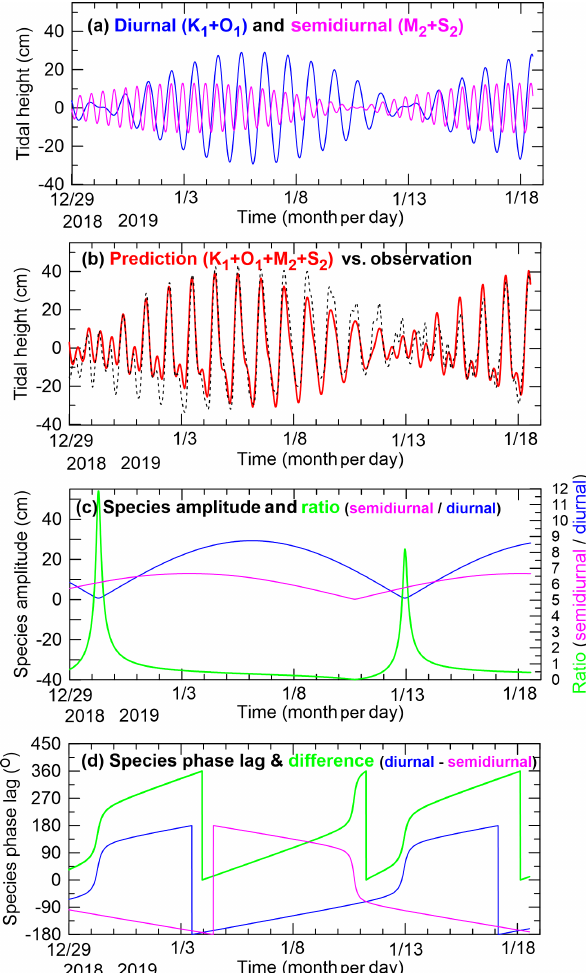
Figure 8. Time series (29 December 2018 to 18 January 2019) of (a) predictions of the diurnal ( K 1 + O 1 ) tides (blue line) and the semidiurnal ( M 2 + S 2 ) tides (magenta line) for JBARS; (b) their combined JBARS predictions (red line) and observations (dashed black line); (c) the ROBT diurnal (blue line) and semidiurnal (ma- genta line) species amplitudes and their ratio (green line); and (d) the ROBT diurnal (blue line) and semidiurnal (magenta line) species phase lags and their difference (diurnal – semidiurnal) (green